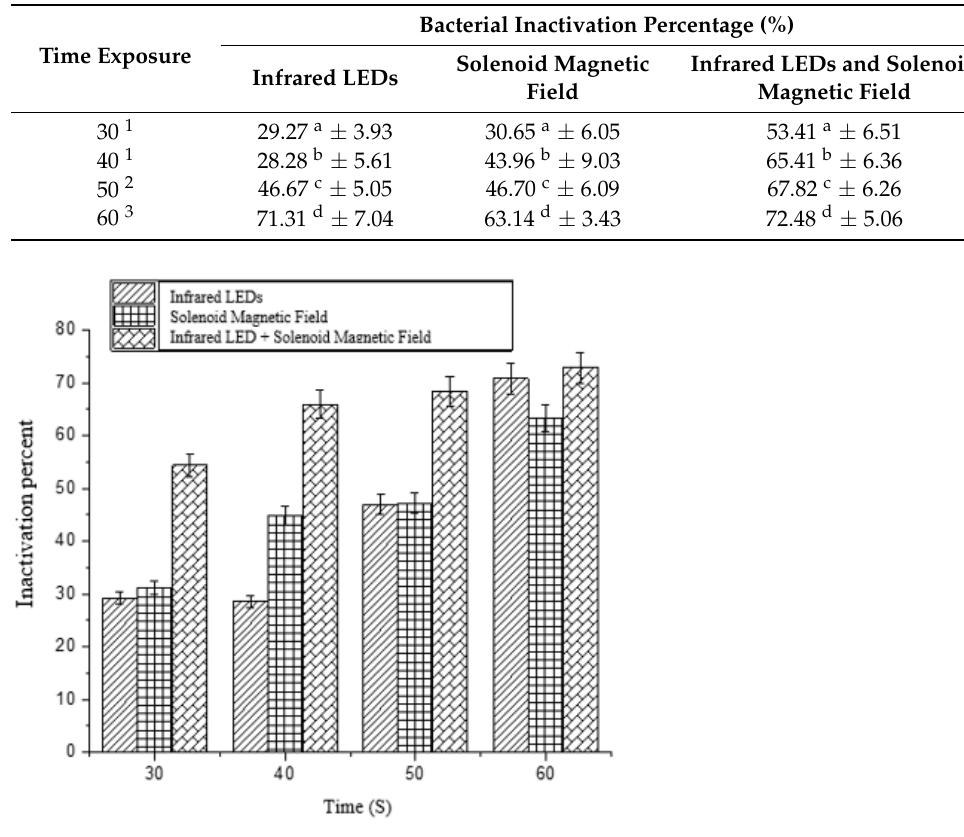
Figure 14. Graph of the percentage of inactivation of bacteria E. coli against time from treatment results. Table 5. Table of conclusions on statistical test results on Escherichia coli bacteria.